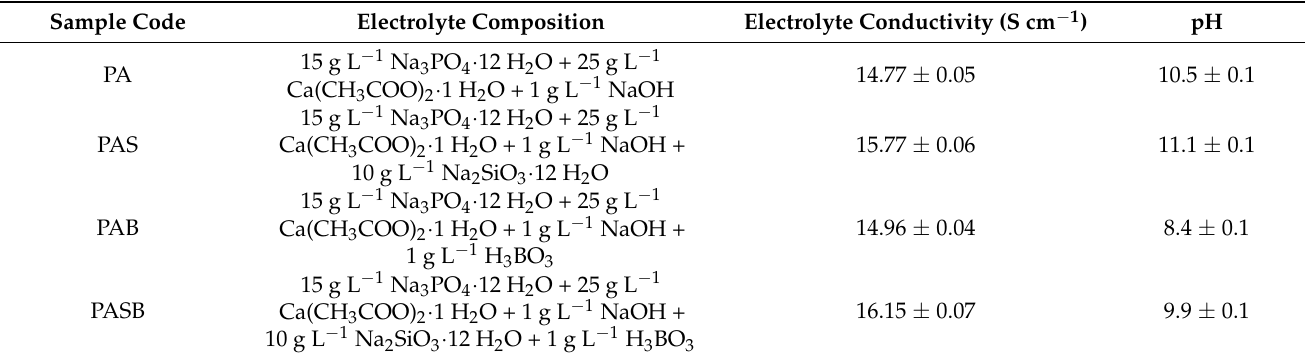
Table 2. Sample codes corresponding to electrolyte compositions. Sample